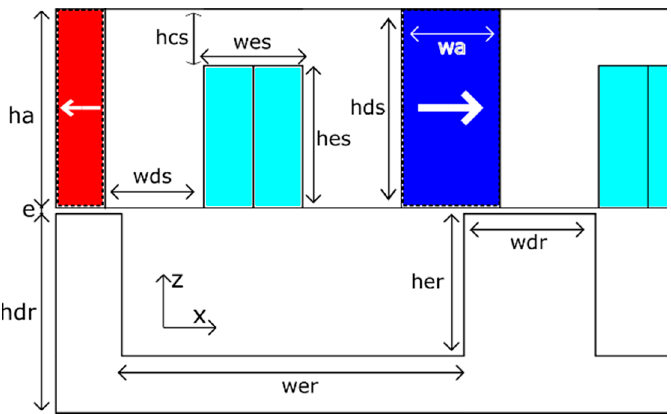
Figure 6. Annotations for the dimensions of the AFSPM linear structure.